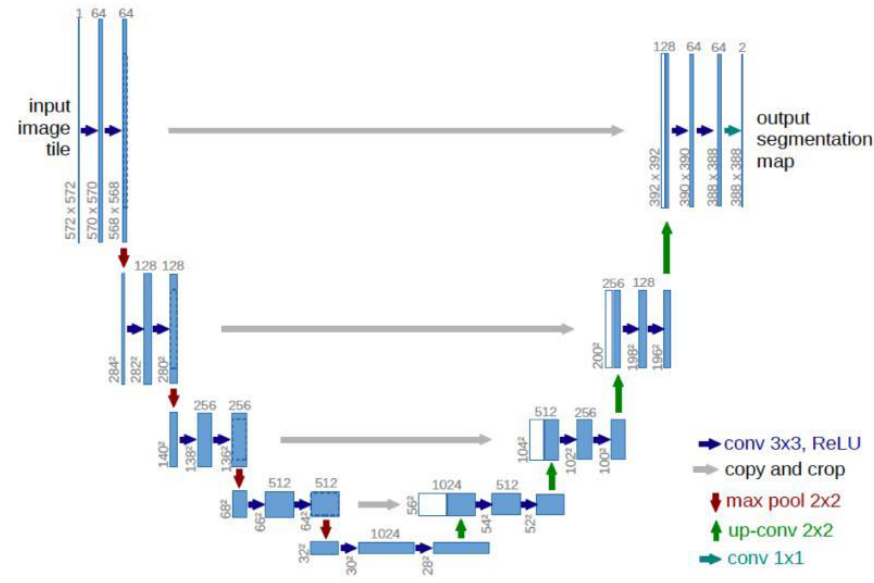
Figure 5. The U-Net algorithm.